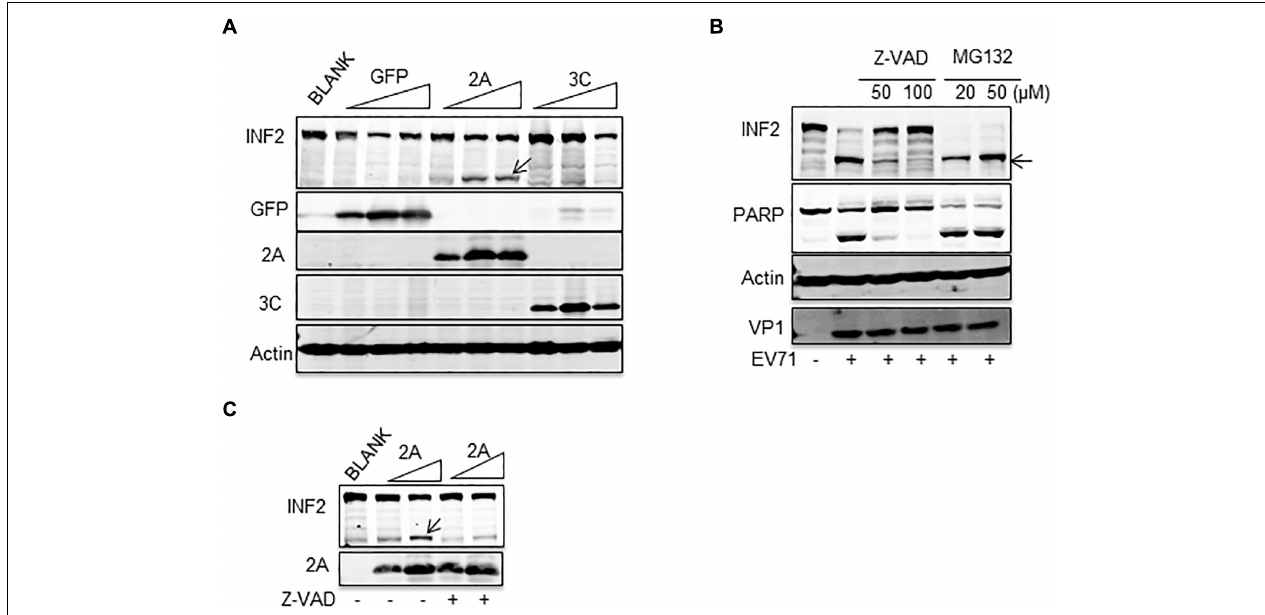
FIGURE 2 | EV71-induced INF2 cleavage was mediated by caspase. (A) BSR/T7 cells were not transfected (BLANK) or transfected with increasing dosage of plasmids encoding GFP control, EV71 2A pro , and EV71 3C pro . Thirty-six h after transfection, the cells were lysed, and a Western blot was conducted to detect INF2, GFP, 2A pro , 3C pro , and actin. Arrows indicate the cleavage fragments (CF). (B) RD cells were mock-infected (–) or infected with EV71 (MOI = 10) for 12 h, Z-VAD-FMK (Z-VAD), and MG132 of different concentrations were added to the culture media 6 h post-infection. Then, the cells were harvested and lysed for Western blot detecting INF2, PARP, Actin, and EV71 VP1. PARP was used as an indicator of caspase activation and the effect of Z-VAD. Arrows indicate the cleavage fragments (CF). (C) BSR/T7 cells were not transfected (BLANK) or transfected with increasing dosages of plasmids encoding EV71 2A pro , 24 h